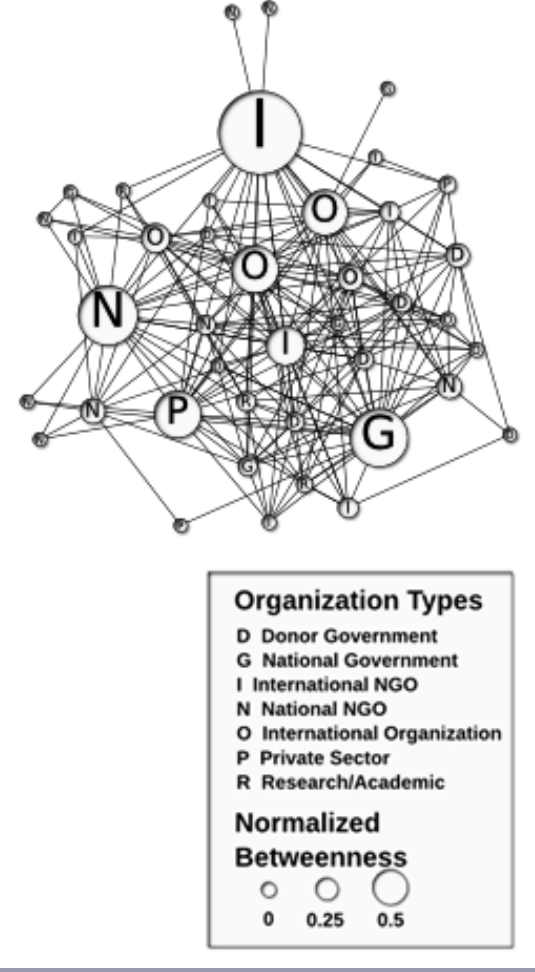
Fig. 3 . Relative influence of actors in the REDD+ policy arena in Cameroon. The size of nodes indicates the number of in-degrees (how often members in the actor group were named as influential by interviewees). The thickness of the ties indicates the number of nominations across actor groups (how often members of a group identified members of another group as influential). Self-nomination